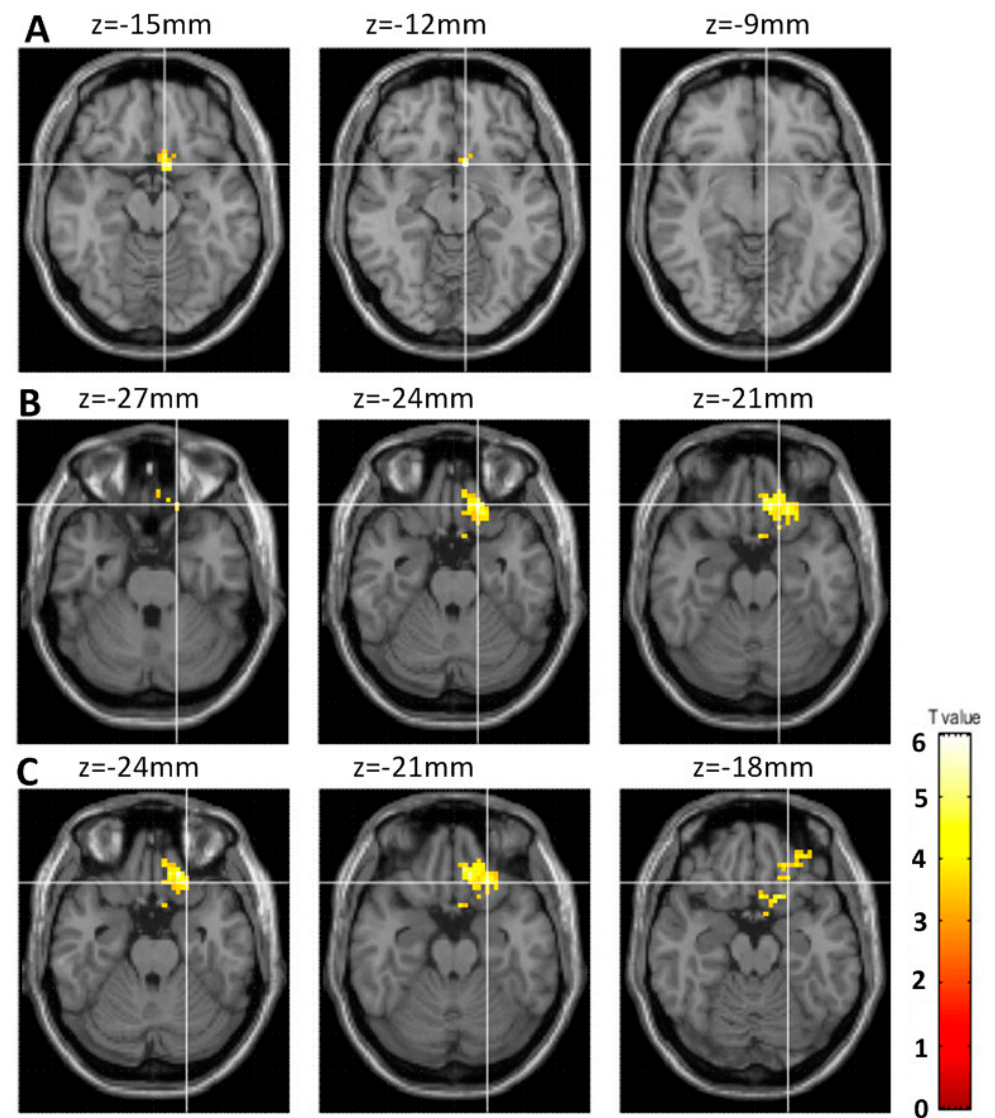
Figure 2. Regions showing differences in the changes of brain activity between the pro-gamer group and IGD adolescent group. ( A ) left subcallosal gyrus (x, y, z, − 6, 12, − 1), ( B ) left orbital gyrus (x, y, z, − 15, 33, − 24), ( C ) left inferior frontal gyrus (x, y, z, − 21, 27, − 21), yellow regions: the IGD adolescent group showed increased brain activity compared to the pro-gamers group.